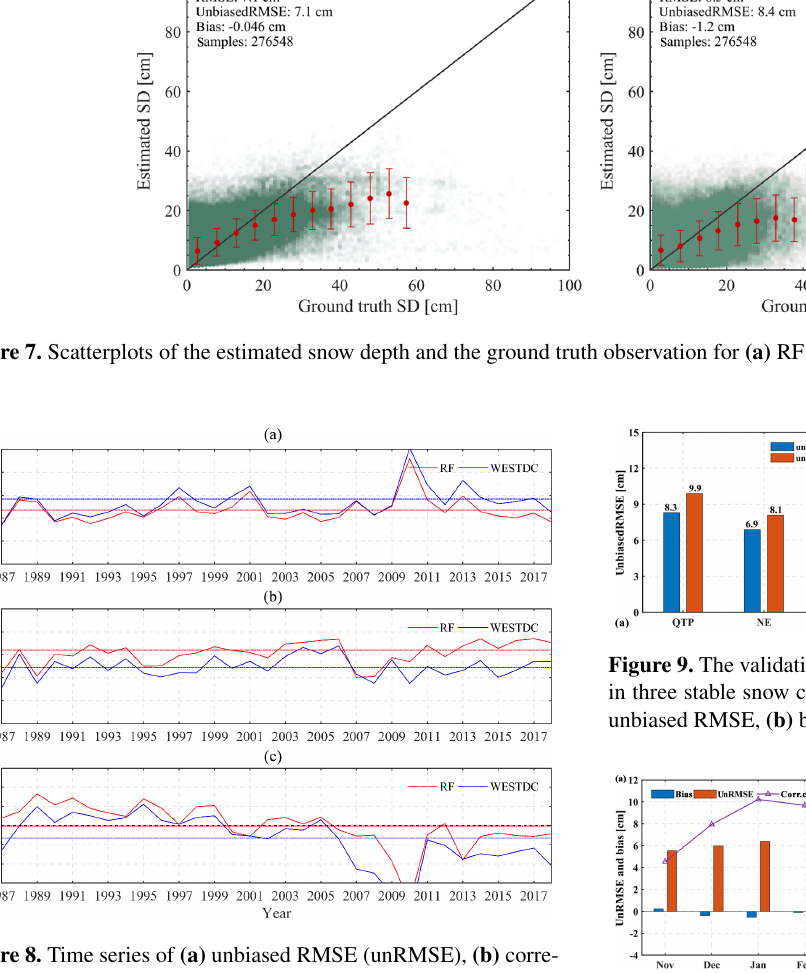
Figure 10. Monthly performances of (a) RF and (b) WESTDC snow depth products. Nov: November; Dec: December; Jan: Jan- uary; Feb: February; Mar: